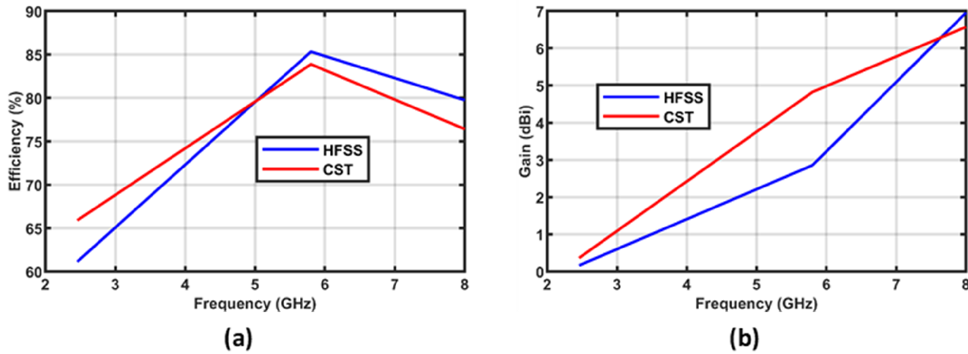
Figure 10. The simulated ( a ) efficiency and ( b ) gain of the proposed antenna.